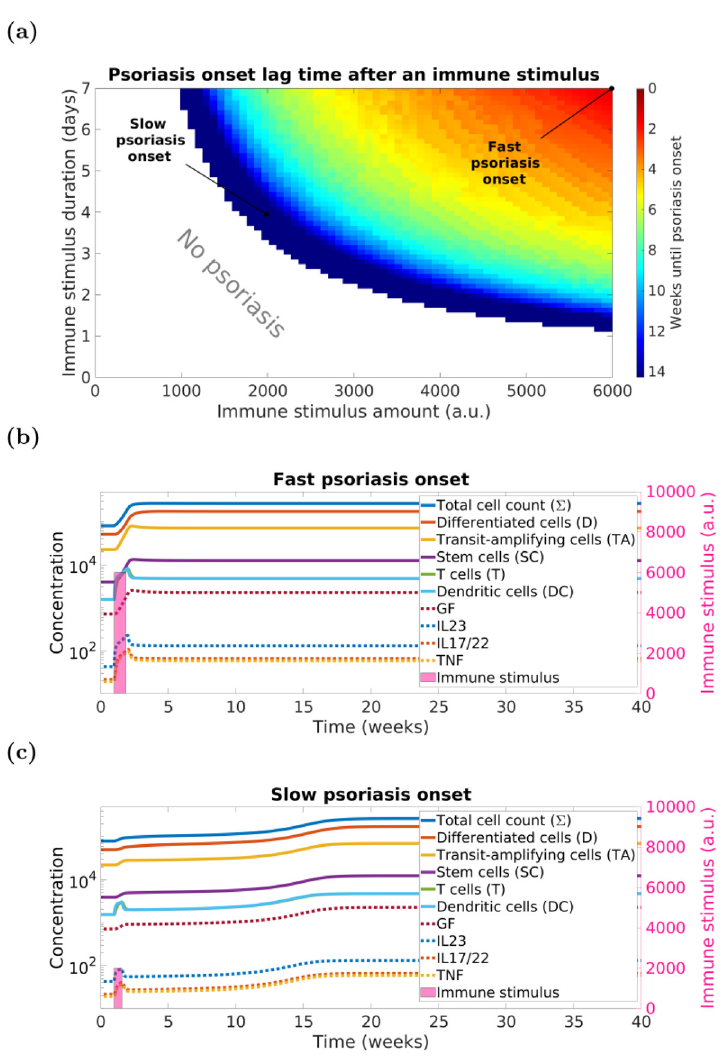
Fig 3. The speed of psoriasis onset in ODE model depends on the strength and the duration of the immune stimulus. Panels: (a)—heatmap where white-coloured area denotes combinations of immune stimulus strength and duration that do not lead to psoriasis; other colours denote psoriasis; (b) and (c)—examples of model simulations for the combinations of stimulus strength and duration values, as highlighted in Panel (a), leading to fast and slow psoriasis onsets, respectively. Psoriasis onset occurs if totC = totC H + 0.9( totC P − totC H ) � 247,376 cells / mm 2 � 0.93 � totC P ( i.e ., the total cell density of the model has covered 90% of the distance between the healthy state and the psoriatic state—see Table 2 for the actual cell densities). This is due to the relatively slow convergence of the model to the psoriatic steady